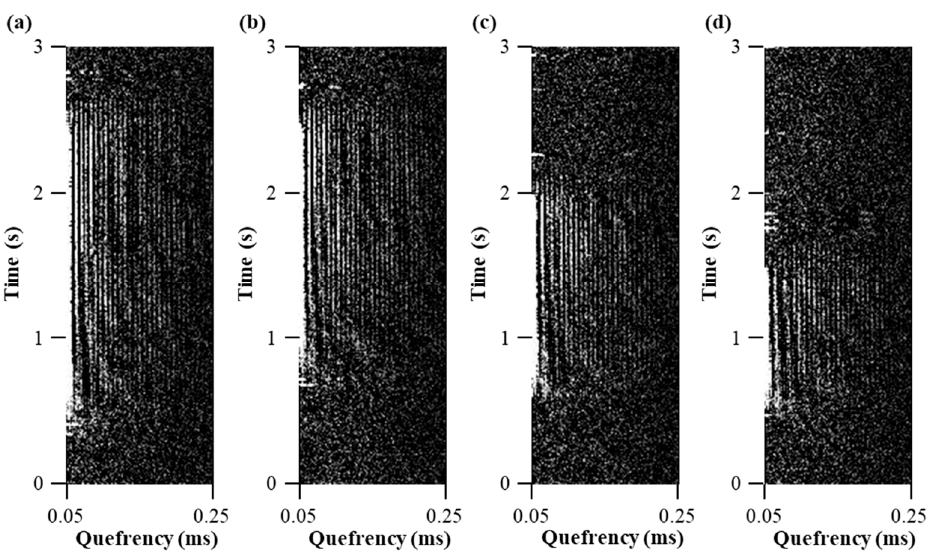
Figure 2. Short-time cepstral coefficients for clamping force of ( a ) 47 kN, ( b ) 37 kN, ( c ) 27 kN and ( d ) 17 kN. Appl. Sci. 2020 , 10 , x FOR PEER REVIEW